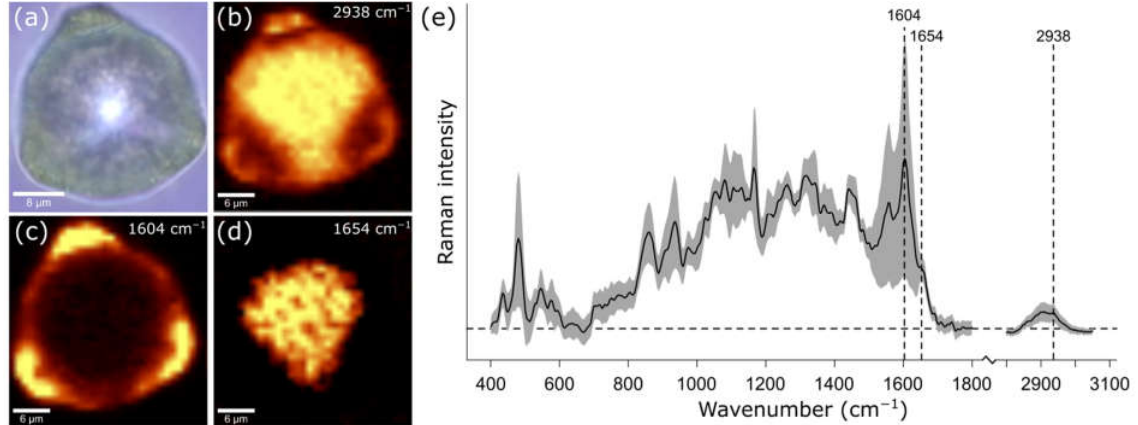
Figure 1. Imaging data of a Betula ermanii pollen grain in ( a ) a bright-field image, ( b ) a Raman intensity map over the CH stretching band between 2800 to 3010 cm −1 , ( c ) a Raman intensity map over 1570 to 1620 cm −1 representing sporopollenin in the grain wall, ( d ) a Raman intensity map over 1620–1680 cm −1 as a typical protein and lipid band. The brighter the color in the intensity maps, the higher the intensity of the respective spectral band. ( e ) The mean spectrum in black and standard deviation in grey of the entire Raman image.